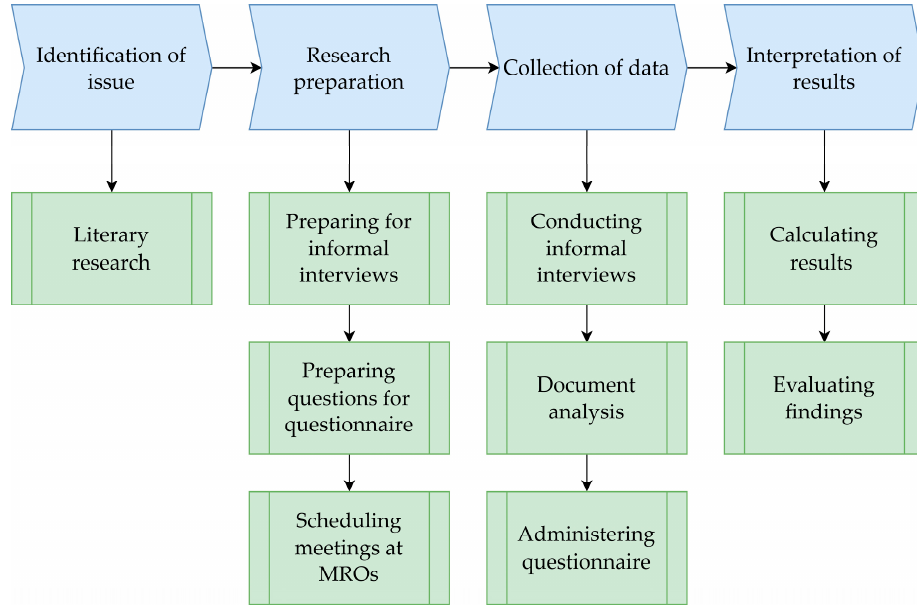
Figure 2. Research framework.